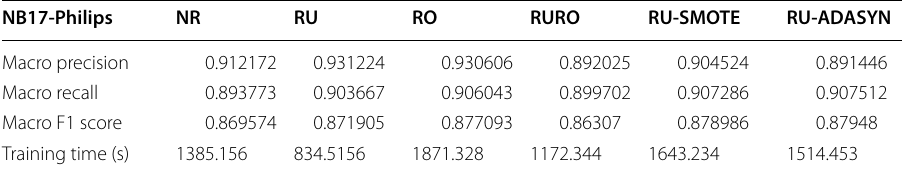
Table 45 ANN classification results for NB17-Philips on local machine for various resampling methods